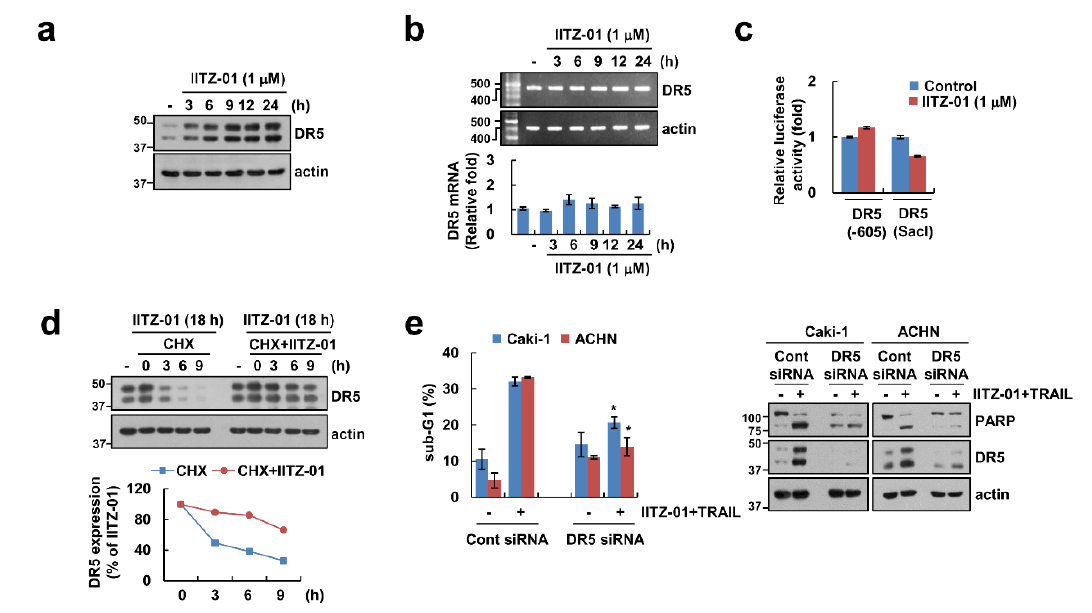
Figure 3. DR5 stabilization contributes to the sensitization effect of IITZ-01 on TRAIL-induced apoptosis in Caki-1 cells. ( a , b ) Caki-1 cells were incubated with 1 μM IITZ-01 for indicated time periods. The protein and mRNA levels were determined by Western blotting ( a ) and RT-PCR (upper panel)/qPCR (low pane), respectively ( b ); (c) Caki-1 cells were transiently transfected with DR5(-605) or DR5(SacI) promoter and incubated with 1 μM IITZ-01 for 18 h. The cells were lysed and the luciferase activity was measured as a described in a Material and Methods; ( d ) Caki-1 cells were incubated with 1 μM IITZ-01 for 18 h, washed with PBS, and then treated with 20 μg/mL cycloheximide (CHX) and/or 1 μM IITZ-01 for the indicated time periods. The band intensity of the DR5 protein was measured using Image J; ( e ) Caki-1 and ACHN cells were transiently transfected with control (Cont) siRNA or DR5 siRNA, and then incubated with 1 μM IITZ-01 and 50 ng/mL TRAIL for 18 h. The apoptotic population (sub-G1) and protein levels were analyzed by flow cytometry (e) and Western blot ( d,e ). The values in graph ( b,c,e ) represent the mean ± SD of three independent experiments. * p < 0.05 compared to the IITZ-01 plus TRAIL in control siRNA.